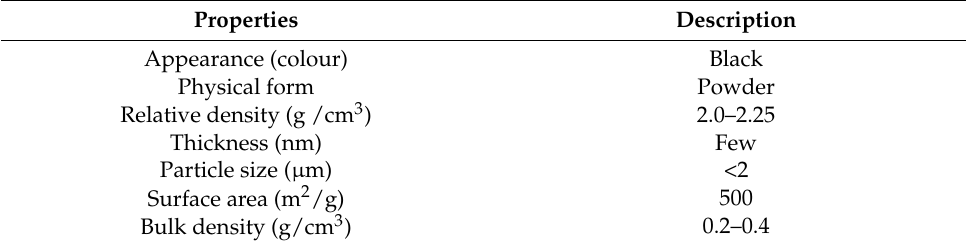
Table 3. Properties of graphene